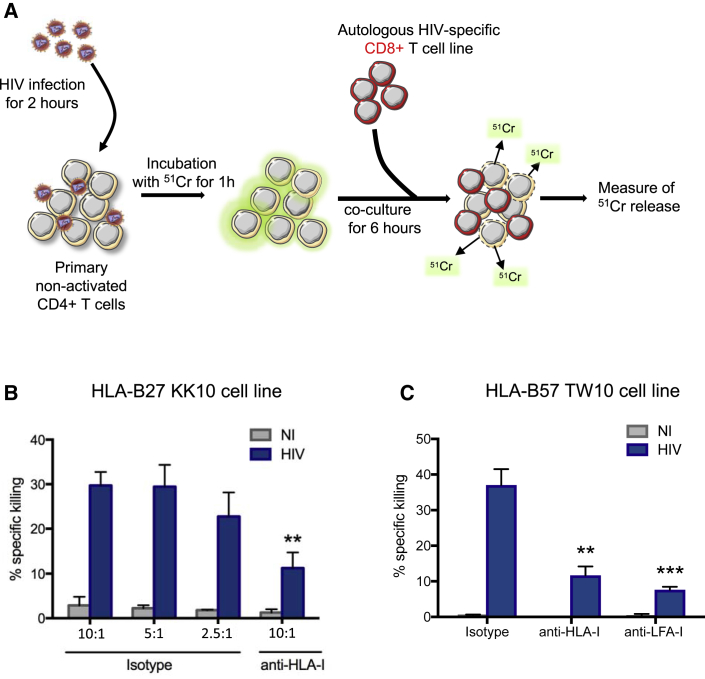
Killing of HIV+ Non-activated CD4+ T Cells by Autologous HIV-Specific CD8+ T Cells(A) Schematic illustration of the experiment.(B and C) Non-activated CD4+ T cells from HIV controllers were infected with HIV-Vpr-βlam+ for 2 h and then incubated with 51Cr for 1 h. The cells were then co-cultured with autologous KK10-specific (B) or TW10-specific CD8+ T cell lines (C) at the indicated effector:target cell ratios for 6 h. Blocking antibodies against HLA-I or LFA-I were added before co-culture, as indicated. The release of 51Cr in the supernatant was measured, and the percentage of specific killing was calculated as [(mean experimental cpm − mean spontaneous cpm)/(mean maximum cpm − mean spontaneous cpm)] × 100.Means ± SDs for two independent experiments in duplicate with cells coming from two different HIV controllers are represented, and statistics were calculated with a two-way ANOVA multiple comparison test relative to 1:10 isotype condition.∗∗p < 0.01 and ∗∗∗p < 0.001.